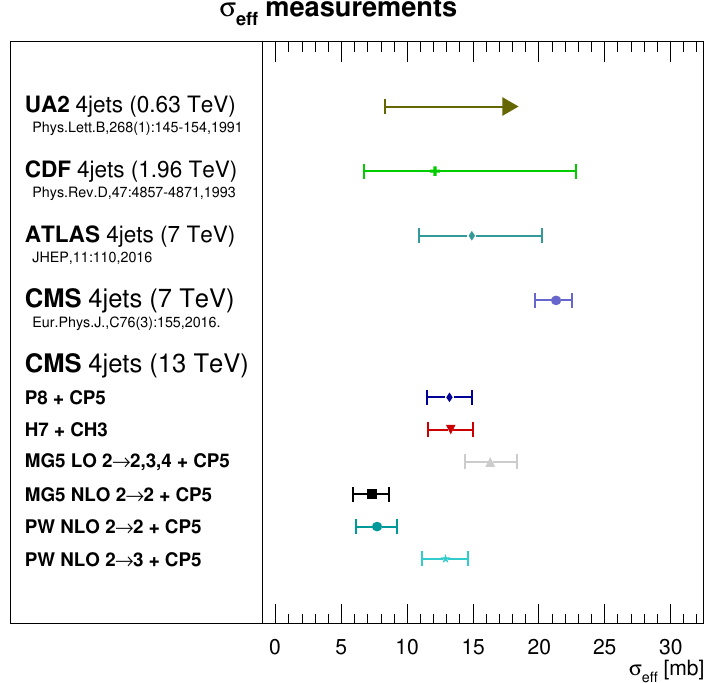
extracted from data using different SPS models eff ≥ 20 GeV, have been T